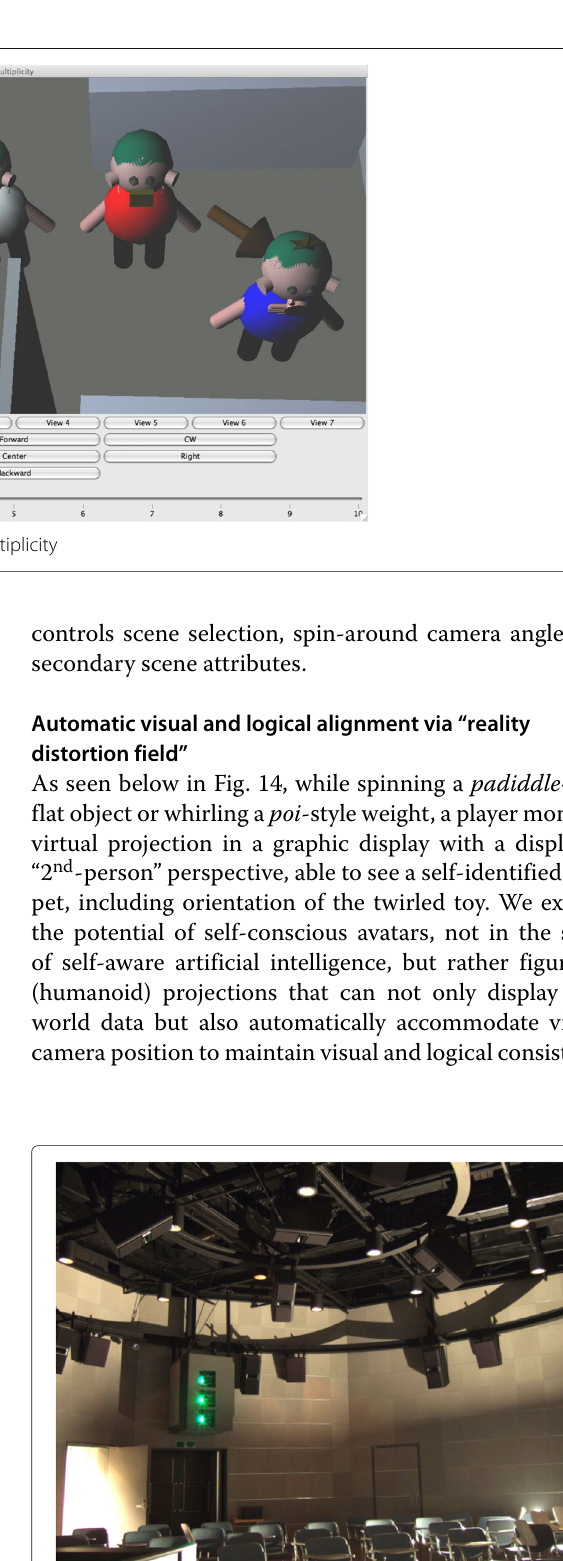
Fig. 8 Spiral Spring Display: For small numbers of rotations, a spiral spring graphical interface (including Chromastereoptic color modulation (Steenblik 1993) for virtual depth) is adequate, but for arbitrary bearing, it quickly runs out of coils